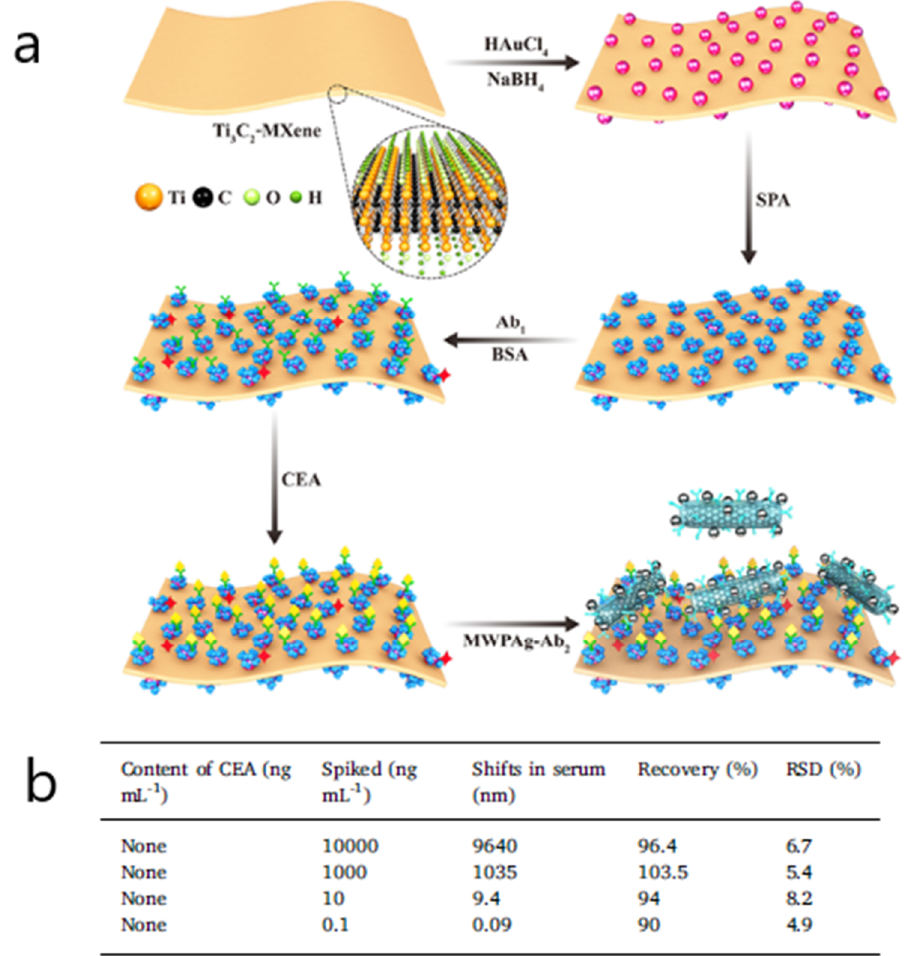
Figure 6. ( a ) Schematic representation showing the detection procedure of the SPR biosensor consisting of a Ti 3 C 2 -MXene-based sensing platform and a multiwalled carbon nanotube (MWCNT)–polydopamine (PDA)–Ag nanoparticle (AgNP) signal enhancer (Ab: antibody; APA: staphylococcal protein A). ( b ) Analytical results of carcinoembryonic antigen (CEA) in human serum. Adapted with permission from Wu et al. [74] (Copyright © (2019) Elsevier).